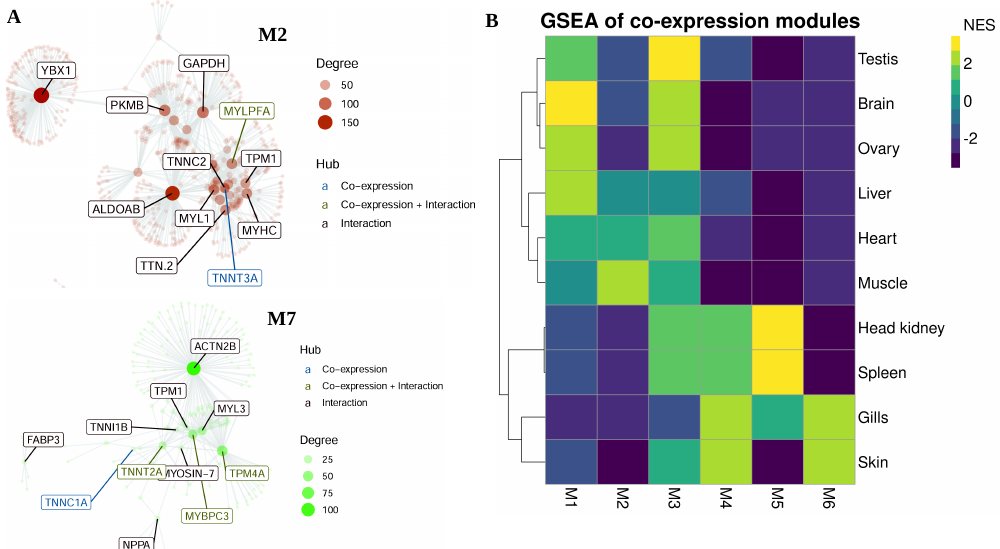
Figure 5. Gene co-expression network analysis. ( A ), Gene co-expression networks of modules M2 (upregulated in muscle tissues) and M7 (upregulated in heart tissues). The top hubs (i.e., genes with highest connectivity) are labelled and coloured based on their source: if only present in the co-expression module predicted by CEMiTool, they are coloured blue; if additionally present in PPI networks, they are coloured green; if exclusively present in PPI network and not in co-expression a network, they are coloured red. The size of the node is proportional to its degree. ( B ), Gene Set Enrichment Analyses (GSA) showing the modules activity on each tissues type. NES is the normalized enrichment score. Exhaustive figures for co-expression modules are available in Supplementary file S4.